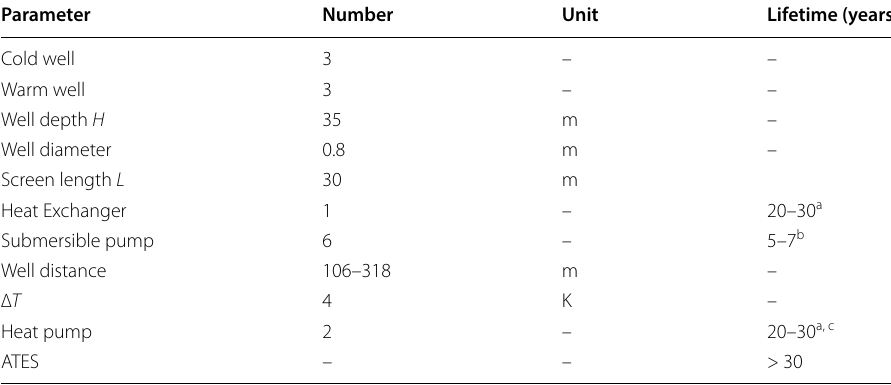
Table 3 Design parameters of the considered ATES